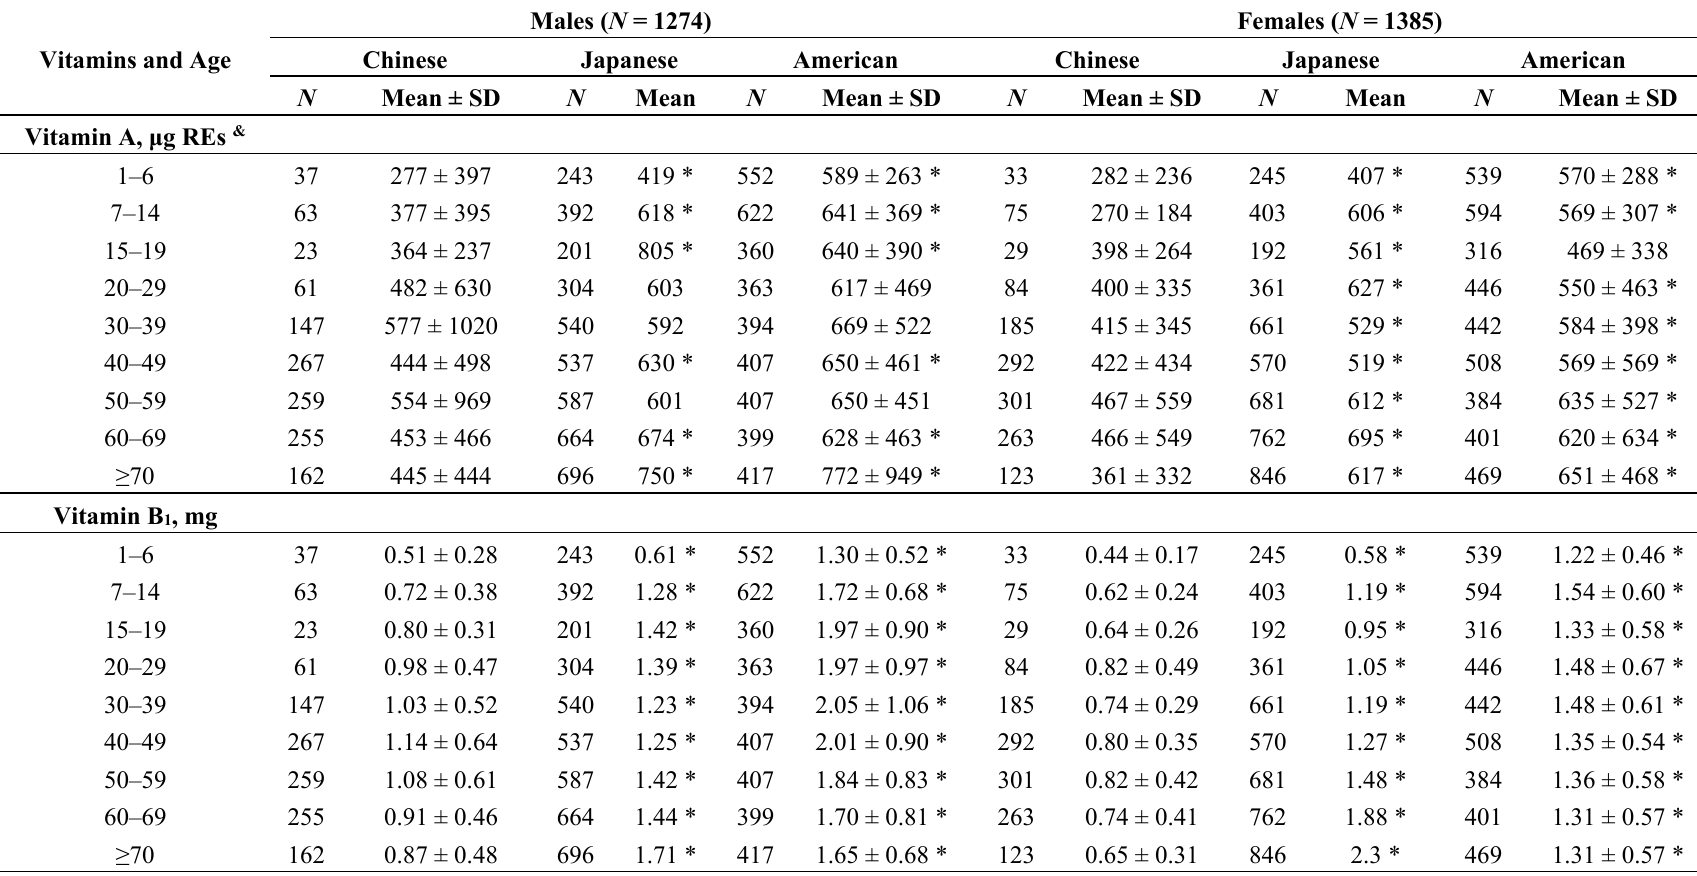
Table 4. Comparison of daily intake of vitamins by age and sex in the Chinese, Japanese and American groups. Vitamins and